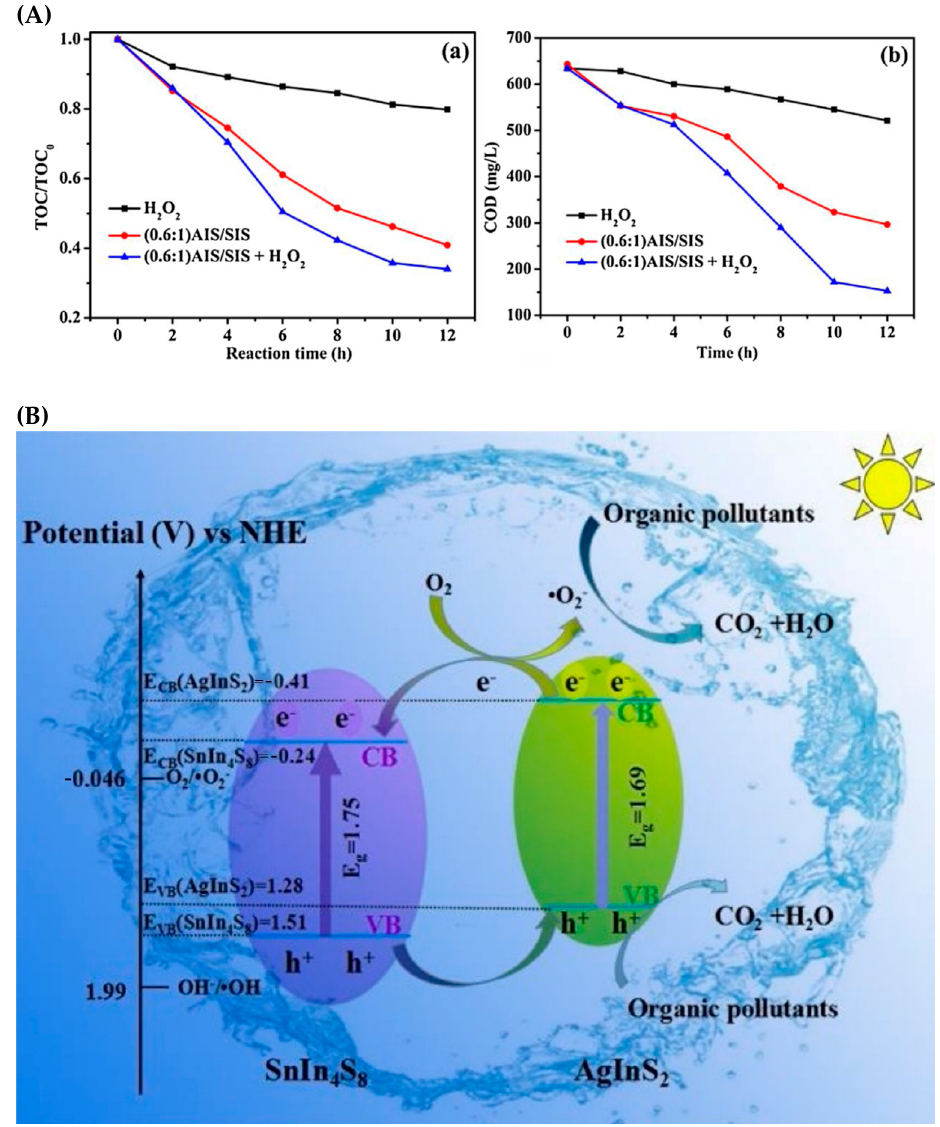
Figure 2. ( A ) The mineralization efficiency of pharmaceutical wastewater ( a ) and the COD removal of real pharmaceutical wastewater by (0.6:1) AIS/SIS heterojunction ( b ). ( B ) Possible photocatalytic mechanism of AIS/SIS heterojunctions (Reprinted from [32], with permission of Elsevier 2017).